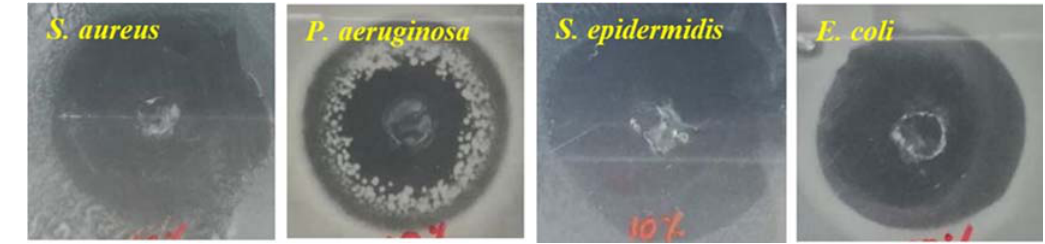
Figure 5. Antimicrobial activity of alginate-based sca ff olds with 10% ( w / w ) cephalexin (CEF)-HNT. Reprinted with permission from [74]. HNT: halloysite nanotubes and CEF: cephalexin.